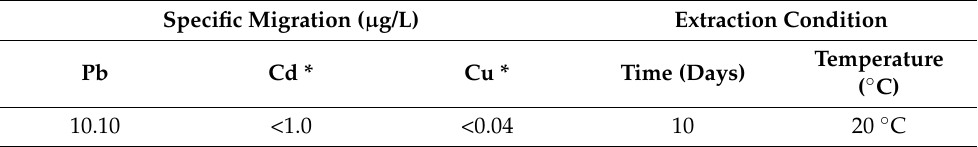
Table 4. Specific migration tests of heavy metals. Specific Migration ( µ